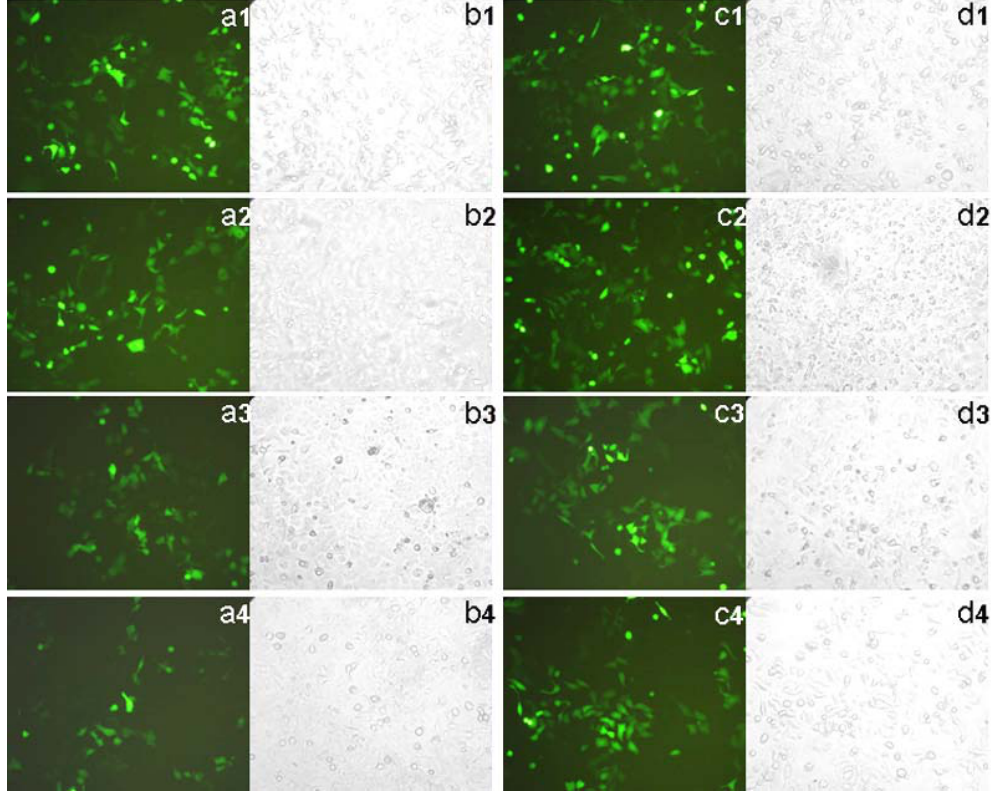
of 10 in different FBS concentration medium (a1, in 10% FBS; a2, in 20% FBS; a3, in 50% FBS; a4, in 100% FBS), HP α -CD-PEI carrying EGFP plasmid at N/P ratio of 50 (c1, in 10% FBS; c2, in 20% FBS; c3, in 50% FBS; c4, in 100% FBS). Image of column a1 to a4 and c1 to c4 were in fluorescence, image of column b1 to b4 and d1 to d4 were in bright